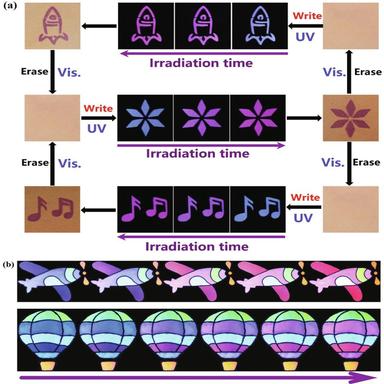
(a) Photo-rewritable paper. (b) Multi-color dynamic fluorescence patterns.